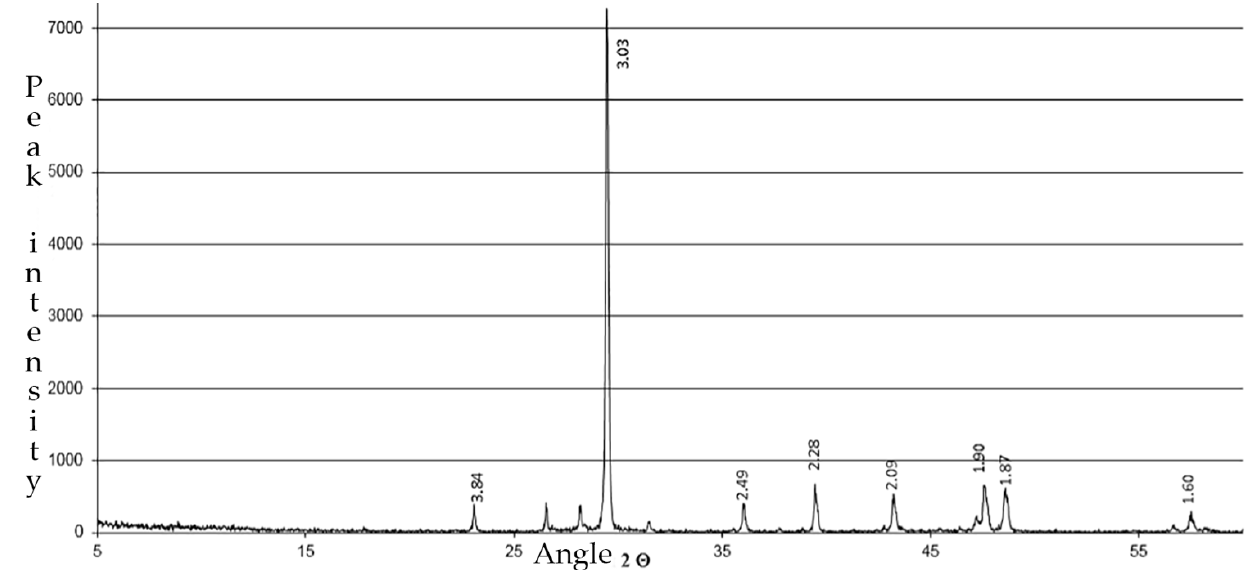
Figure 10. X-ray powder diffraction pattern of marmorized limestone.